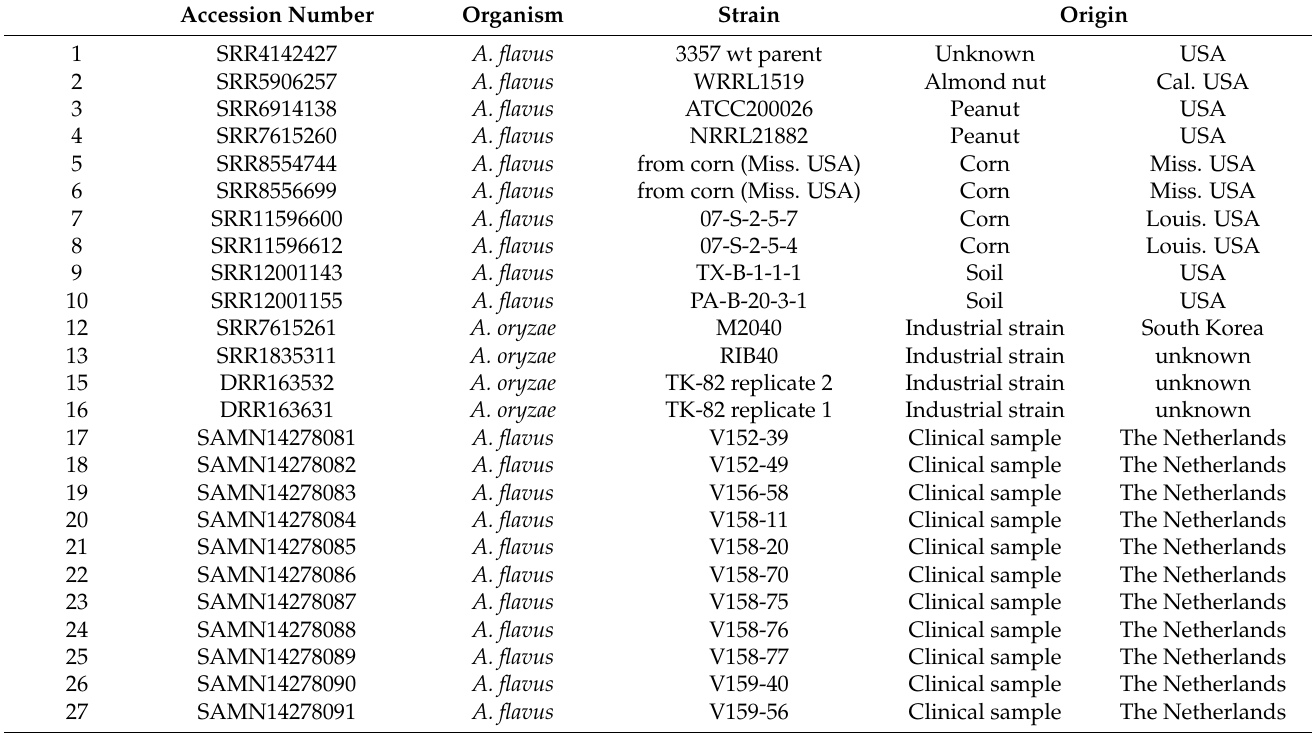
Figure A2. Maximum-likelihood phylogenetic tree of the 11 A. flavus isolates. Table A1. Strain information including accession numbers of the strains used for phylogenetic analysis based on whole- genome sequencing data.